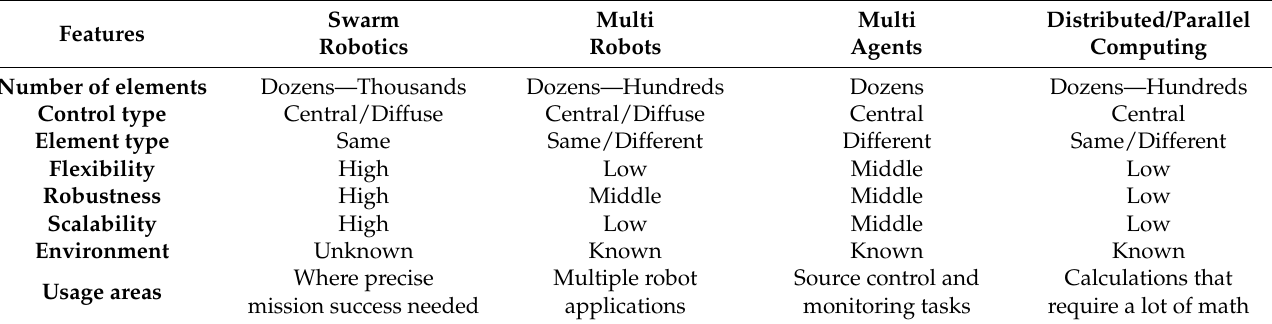
Table 1. Distinctive features of Multi Robots Systems